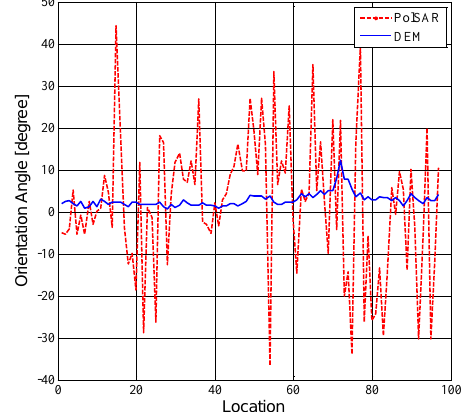
Figure 6. OAS derived by circular polarization and DEM method along the central flow line of Big Dongkemadi Glacier.